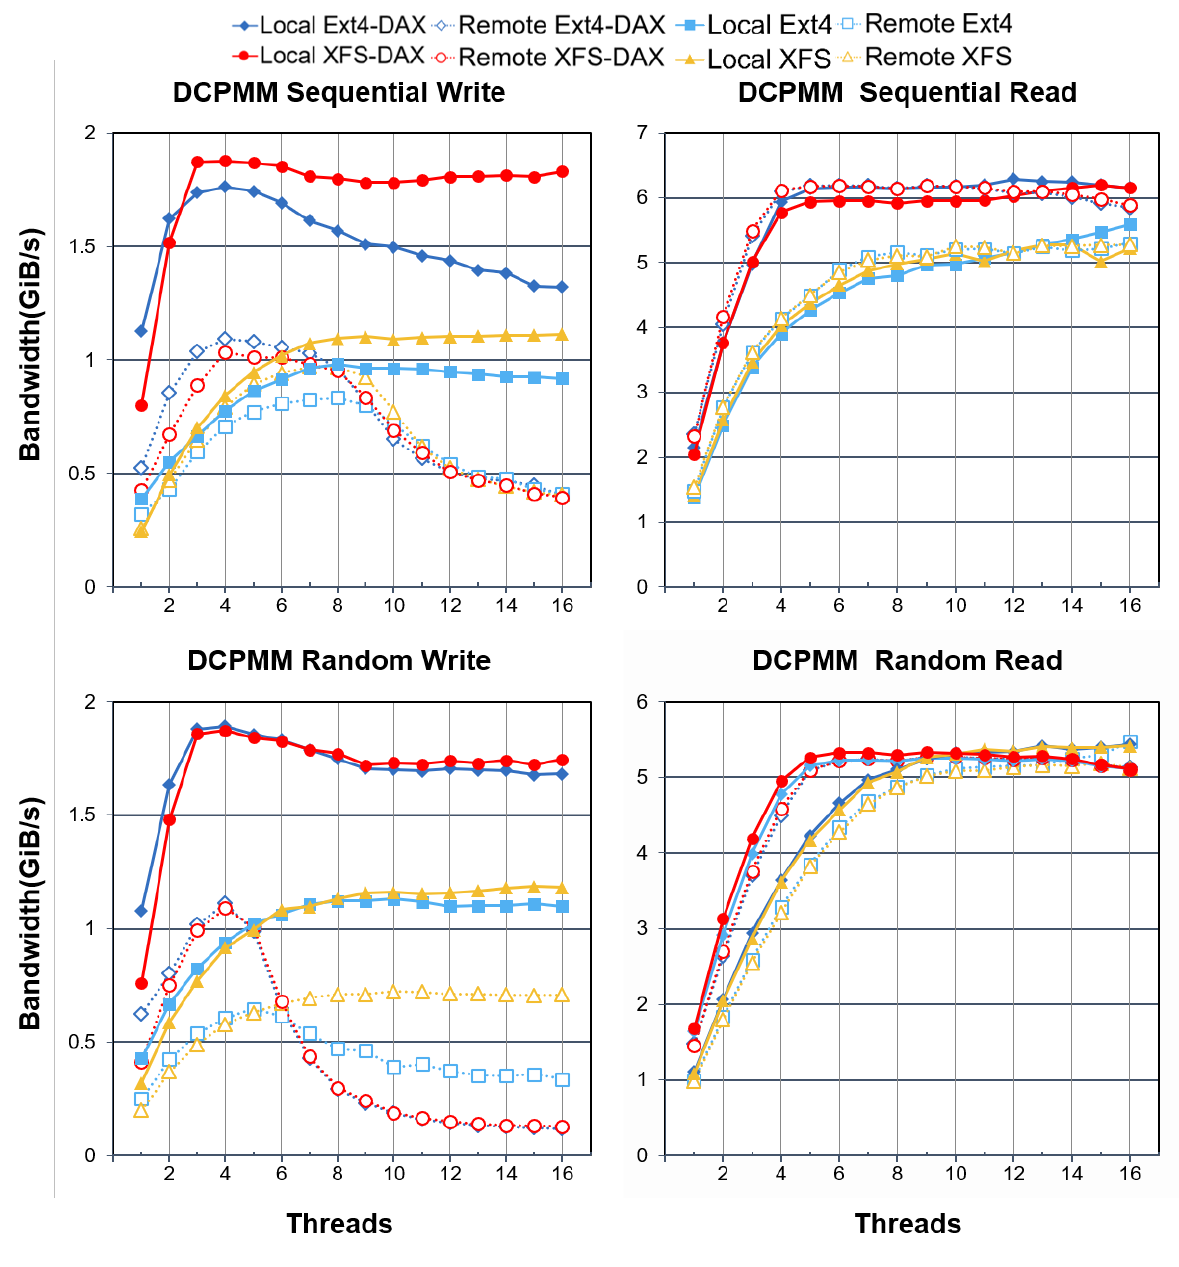
Figure 2. The performance of traditional and NVM-aware file systems on DCPMM when accessed from remote